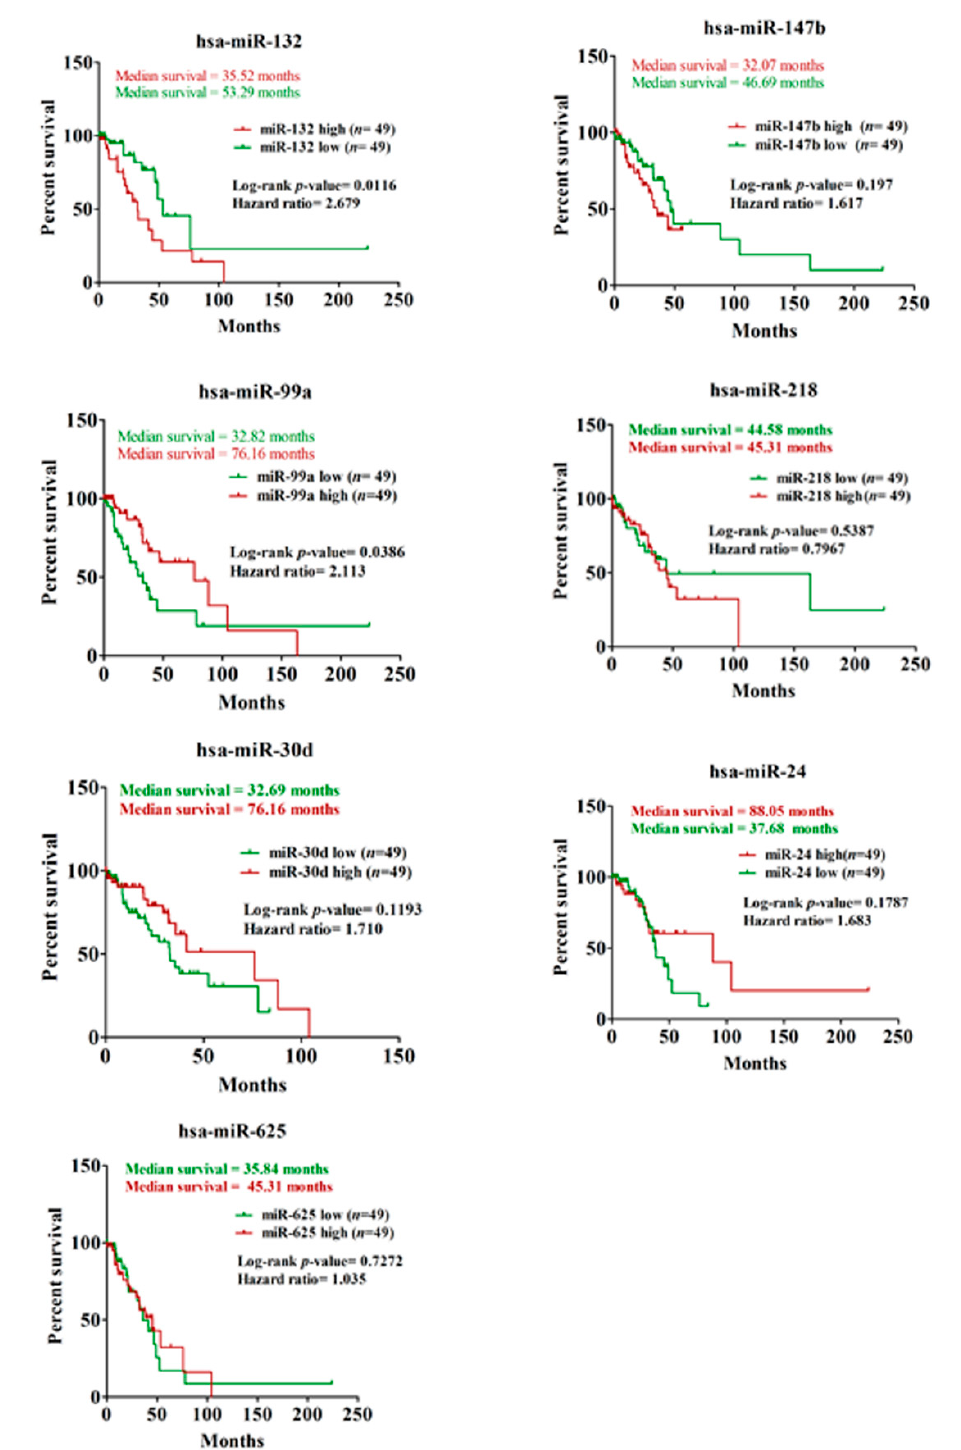
Figure 6. Mutant p53 R273H -regulated miRNAs determine poor survival in lung adenocarcinoma patients. Kaplan–Meier analyses showing relative survival probabilities of lung adenocarcinoma patients with high ( ≥ 75th percentile) and low ( ≤ 25th percentile) expression of the individual mutant p53-regulated miRNAs. Log-rank p -value, hazard ratio, and median survival time are indicated. n indicates the number of patients in respective miRNA low and high groups.